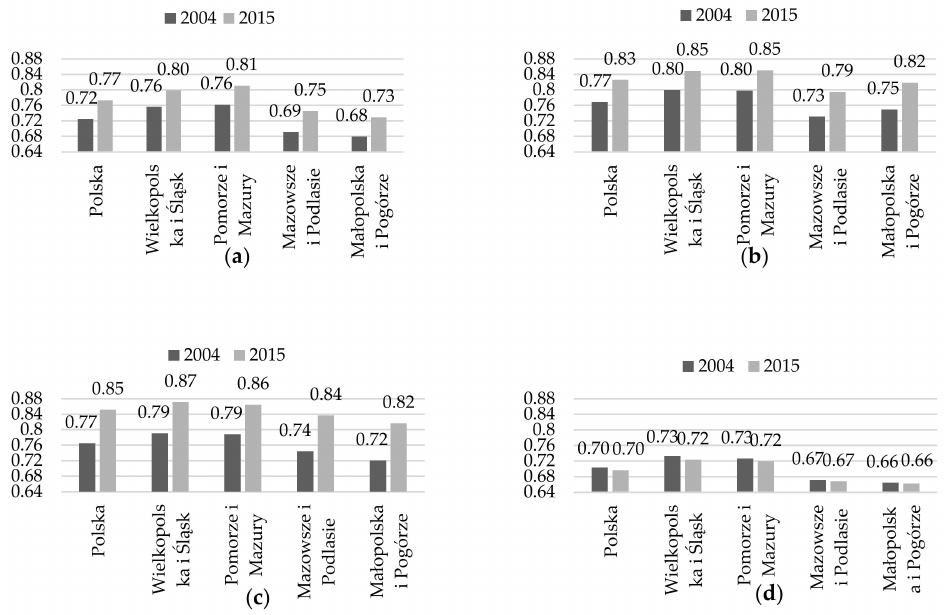
Figure 5. Changes in average technical efficiency of farms in individual regions of Poland depending on the overinvestment group in 2004–2015. ( a ) optimum investment level; ( b ) absolute overinvest- ment; ( c ) relative overinvestment; ( d ) underinvestment. Source: own elaboration based on the EU-FADN–DG